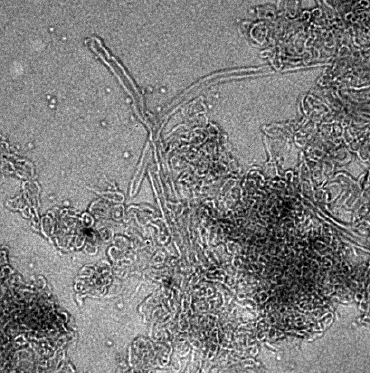
Figure 5. 80 kX TEM images of PSS-SWNTs after e-beam damage which effectively removed the spherically collapsed polyelectrolyte